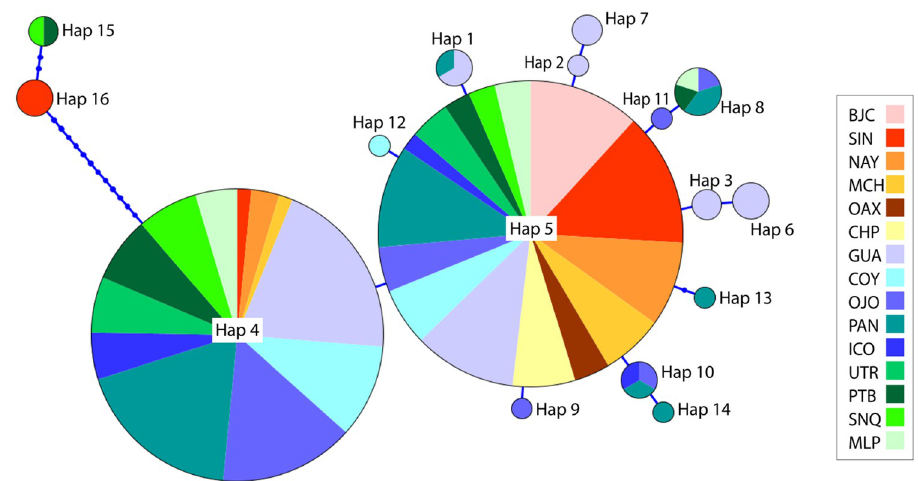
Fig 2. Haplotype network based on mitochondrial control region sequences for Sphyrna lewini . Each circle represents a unique haplotype (Haplotype 1 through 16); the size of the circle is proportionate to the number of individuals; the colors represent the proportion of individuals from each sampling location; ticks on connecting lines indicate mutational steps between haplotypes. Sampling sites: Guatemala (GUA), Ojochal (OJO), Coyote (COY), Cocos Island (ICO), Panama (PAN), Nayarit (NAY), Oaxaca (OAX), Michoacan (MCH), Baja California (BJC), Chiapas (CHP), Sinaloa (SIN), Port Buenaventura (PTB), Sanquianga (SNQ), Utria (UTR), Malpelo Island (MLP).